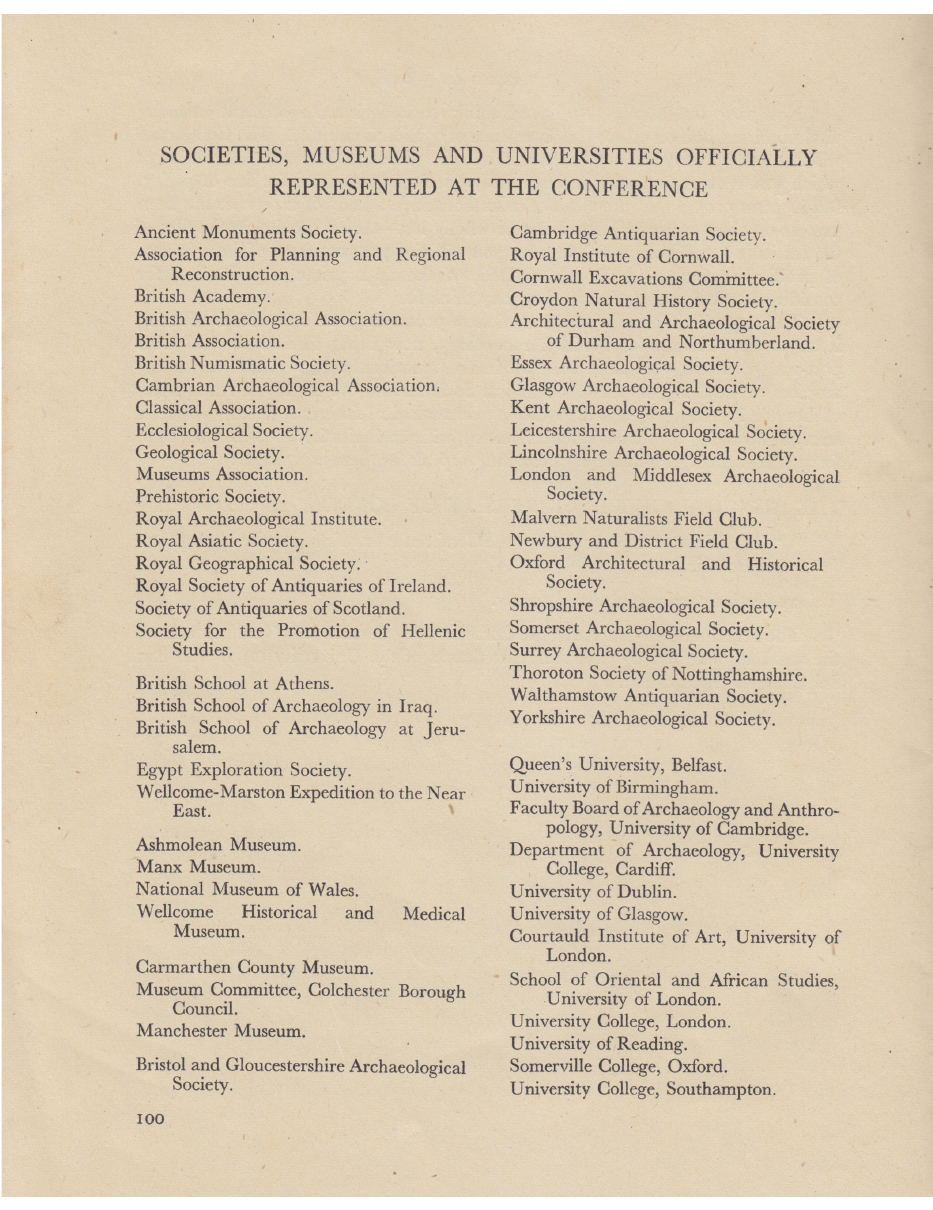
Fig. 5: List of organisations represented at the conference (from CFA ,